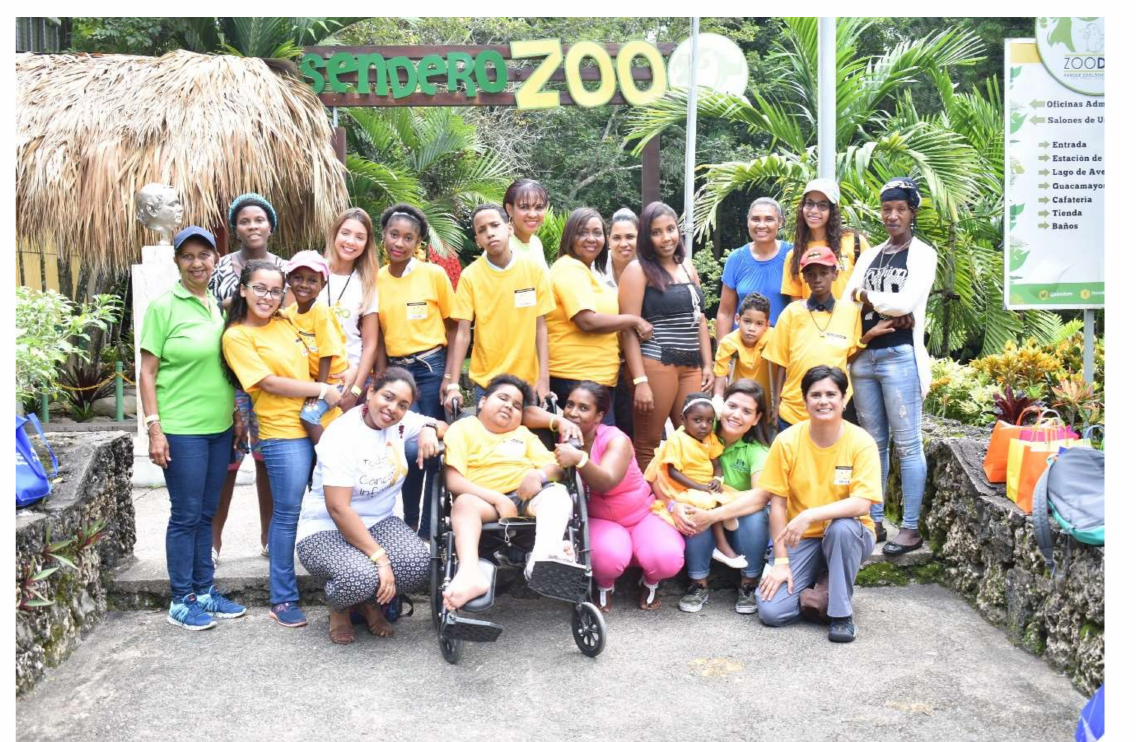
Figure 4. Visit to the zoo with patients, families, team and volunteers of Dominican Republic’s Palliative Care